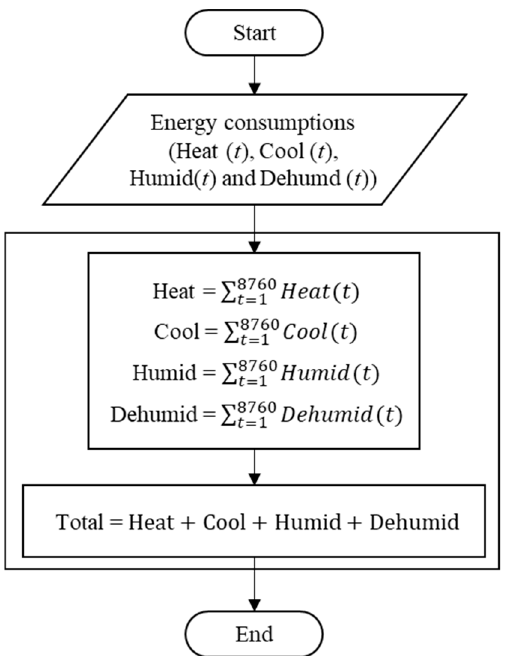
Figure A2. Procedure for quantifying the energy consumptions developed in MATLAB.